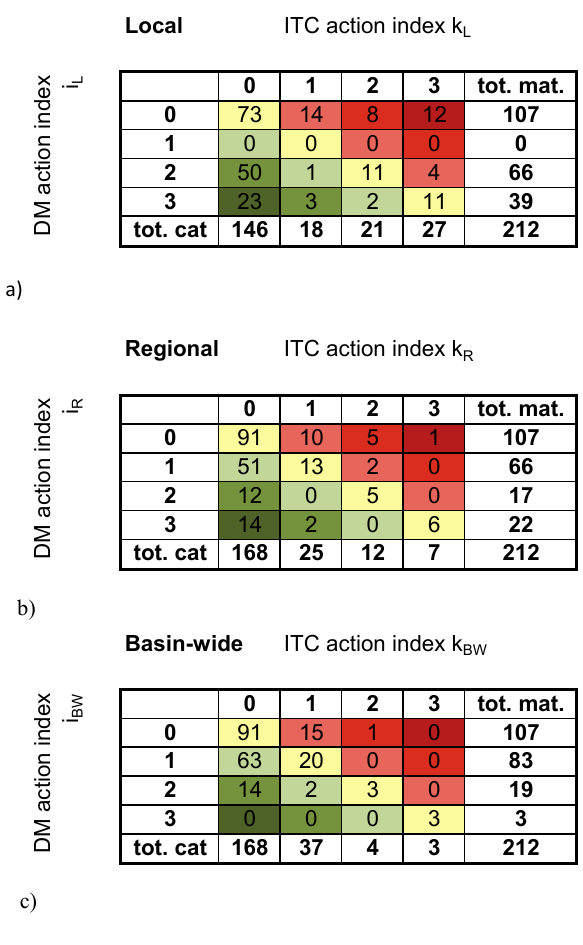
Fig. 2. Matrices comparing DM vs. ITC actions at local (a) , re- gional (b) and basin-wide (c)